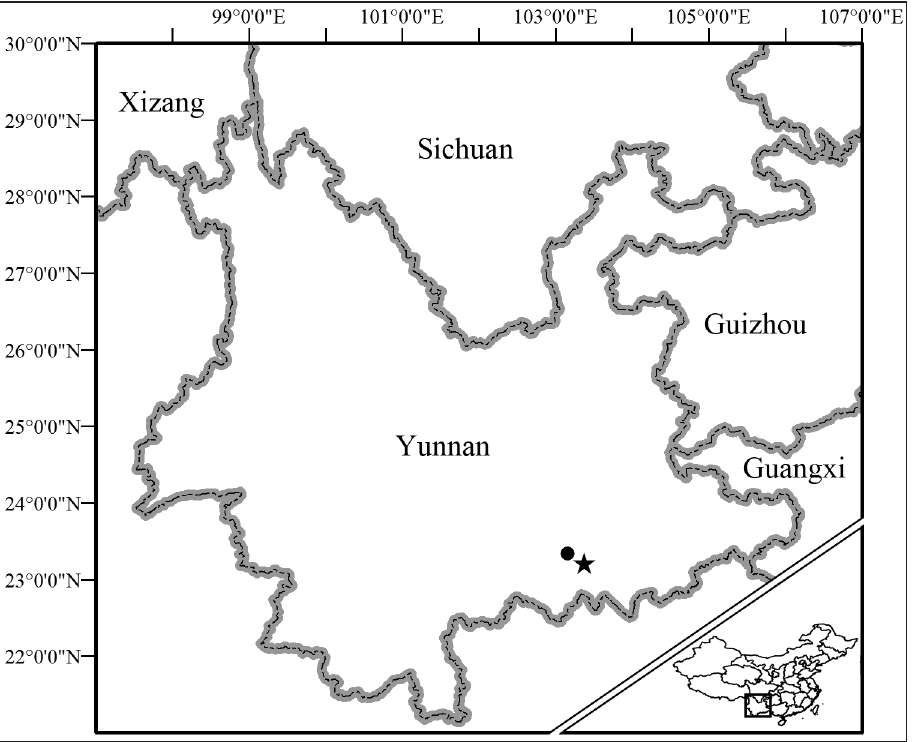
Figure 1. Known distribution of Kurixalus lenquanensis sp. n. Filled star indicates the type locality and filled circle indicates Yangjiatian